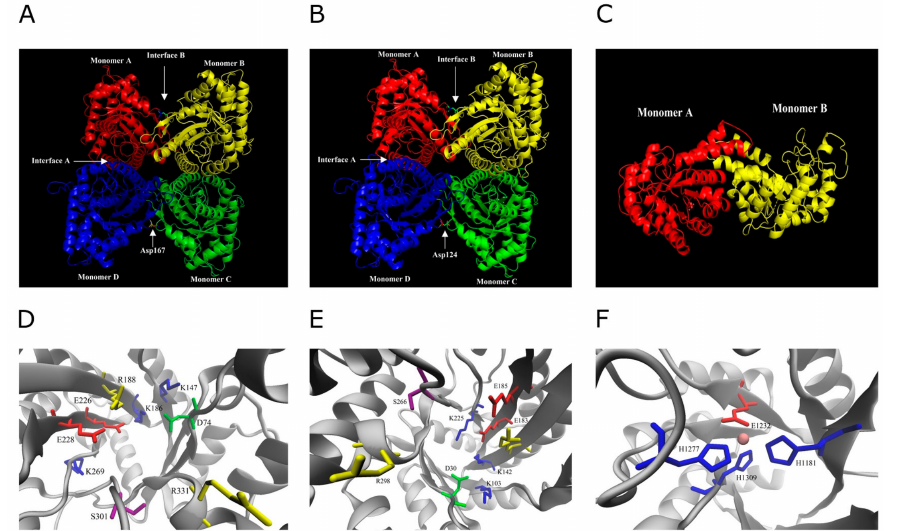
Figure 3. Predicted three-dimensional model of representative Brassica napus Fructose-1,6-bisphosphate aldolase (BnaFBA) proteins. ( A ) Tetrameric BnaFBA1a. ( B ) Tetrameric BnaFBA8a. ( C ) Dimeric BnaFBA9a. ( D ) Active site residues of BnaFBA1a. ( E ) Active site residues of BnaFBA8a. ( F ) Active site residues of BnaFBA9a. The sites of the Asp167 / 124 substitutions are indicated on interface B, and the filled circle represents the divalent metal cation of